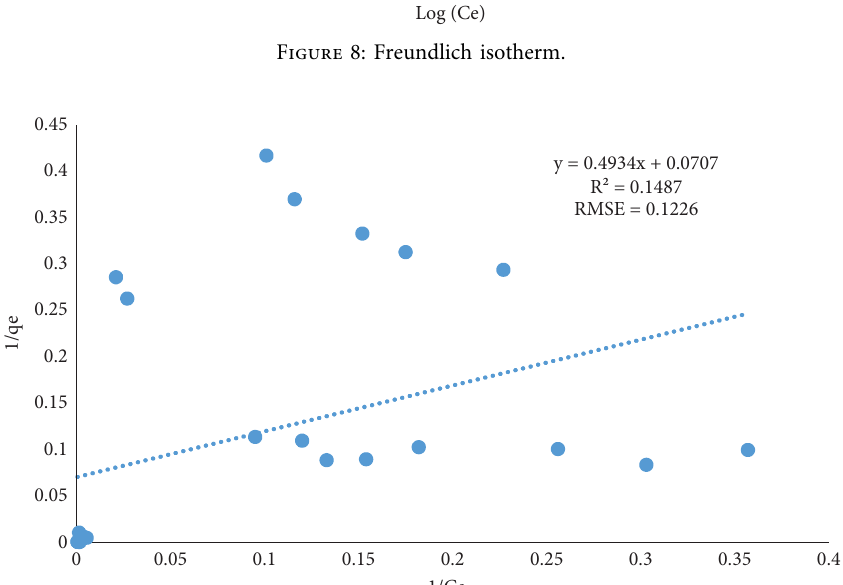
Figure 8: Freundlich isotherm.